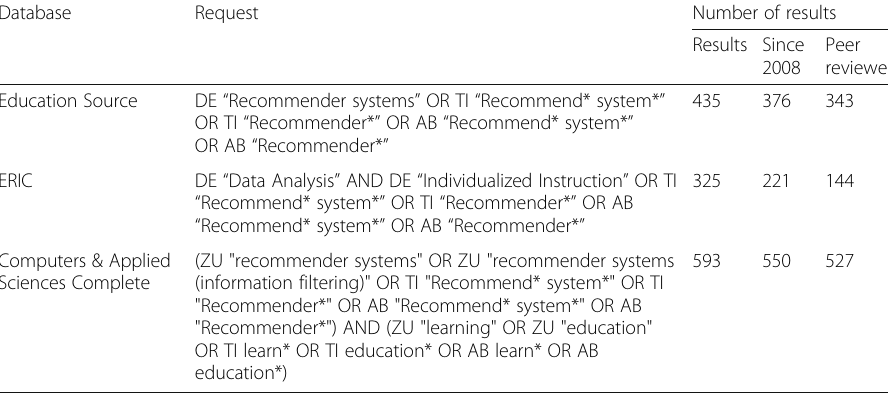
Table 1 Requests by